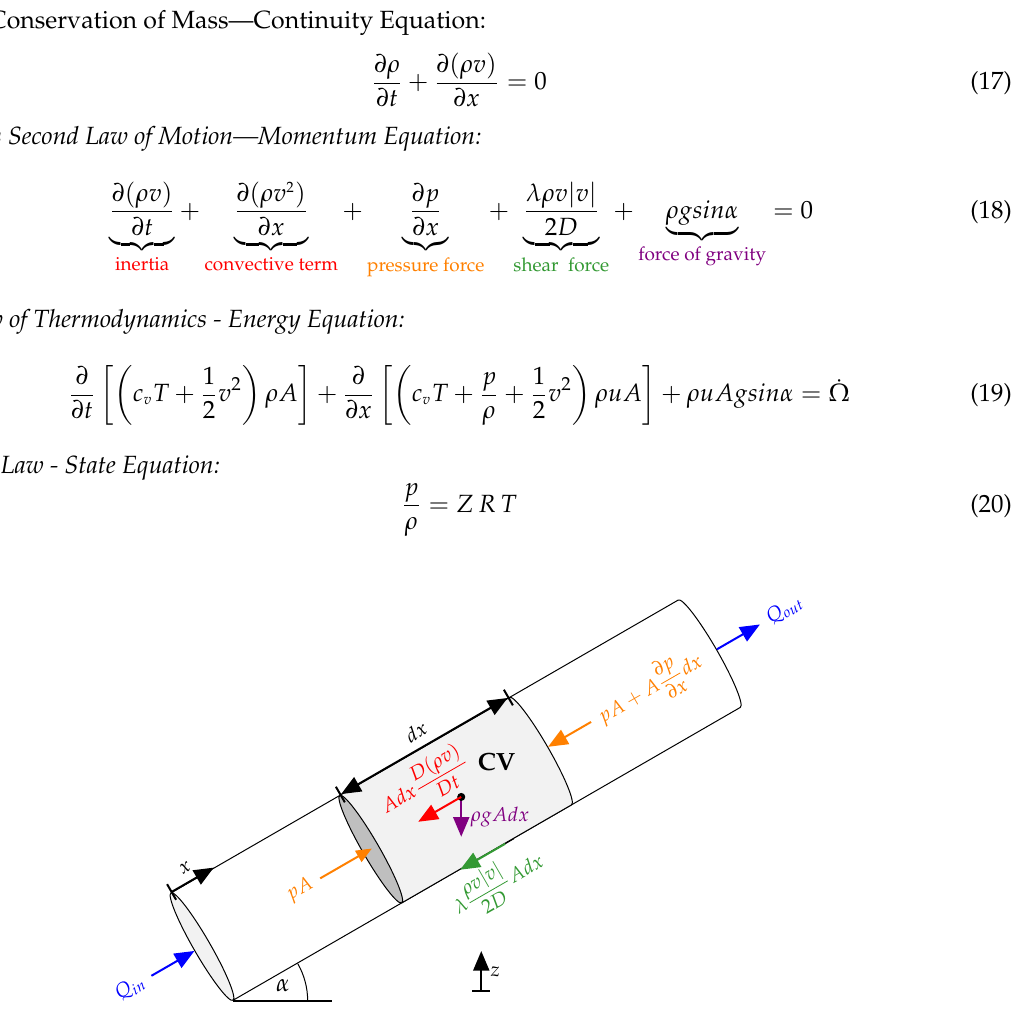
Figure 2. Forces acting on a control volume in a general gas